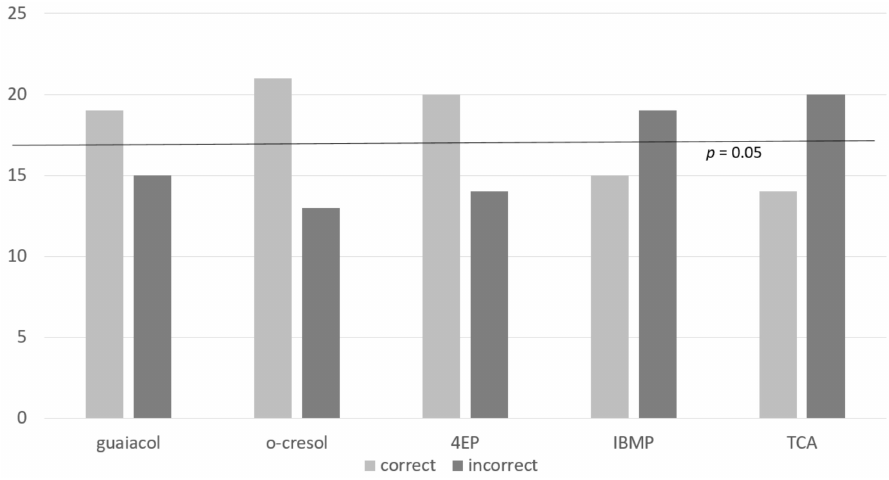
Figure 1. Correct vs incorrect judgments per compound ( n = 34